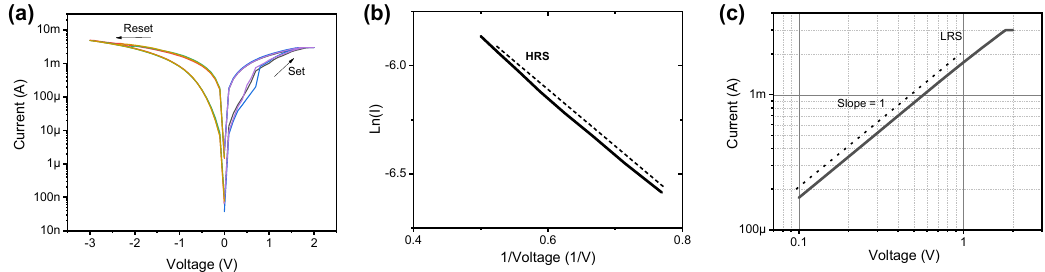
Figure 3. ( a ) Set and reset I-V characteristics, ( b ) Ln(I) versus 1/V fitting for high-resistance state (HRS), ( c ) Log-log scale for Ohmic conduction in the low-resistance state (LRS).